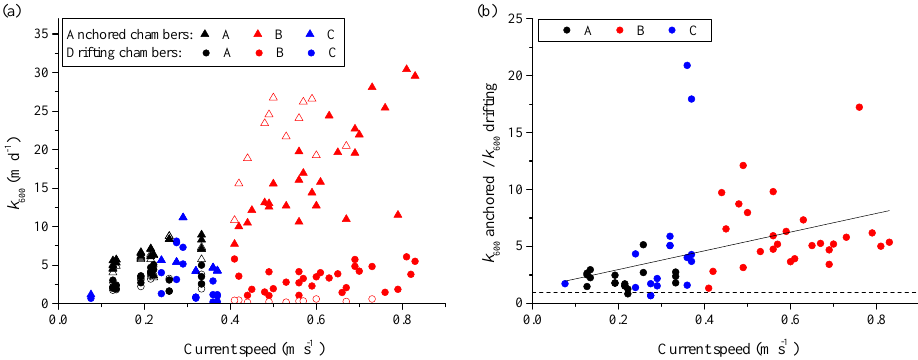
Figure 2. (a) Gas exchange velocity k 600 from anchored (triangles) and drifting (circles) chambers versus current velocity for the three field data sets (A–C, colors). Filled symbols show data obtained from CO 2 , open symbols are based on CH 4 fluxes. (b) Ratio of the gas exchange velocities from anchored and drifting chambers versus current speed (filled symbols: CO 2 ; open symbols: CH 4 ; colors correspond to the different data sets). The dashed line indicates a constant ratio of 1 and the solid line shows a linear regression of the combined data sets ( r S = 0 . 66, p< 0 . 001).